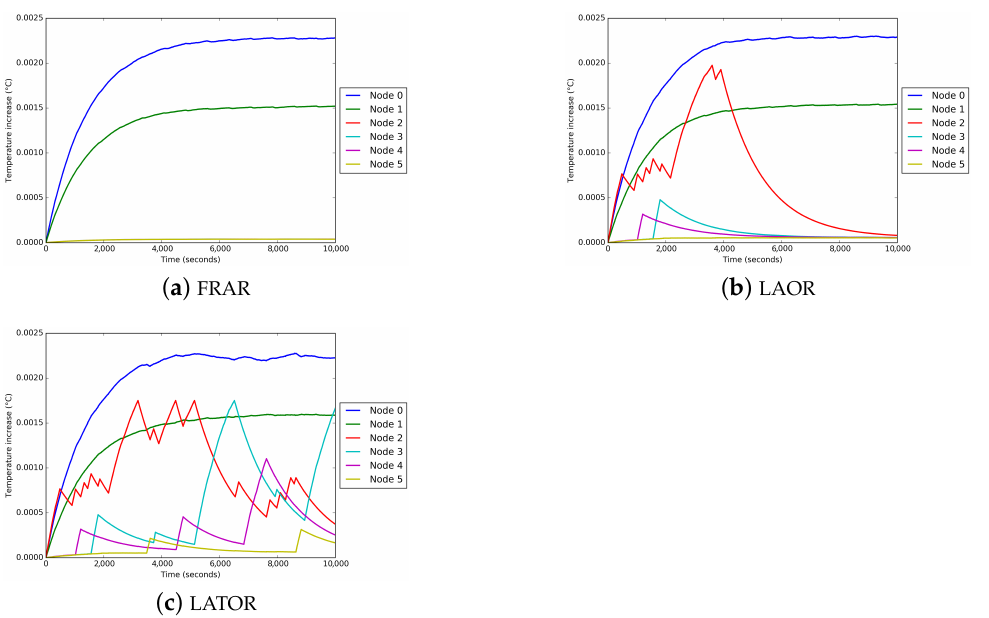
Figure 11. Temperature variation of the nodes. Node 1 acting as transmitter. ( a ) Using FRAR protocol; ( b ) using LAOR protocol; ( c ) using LATOR protocol.